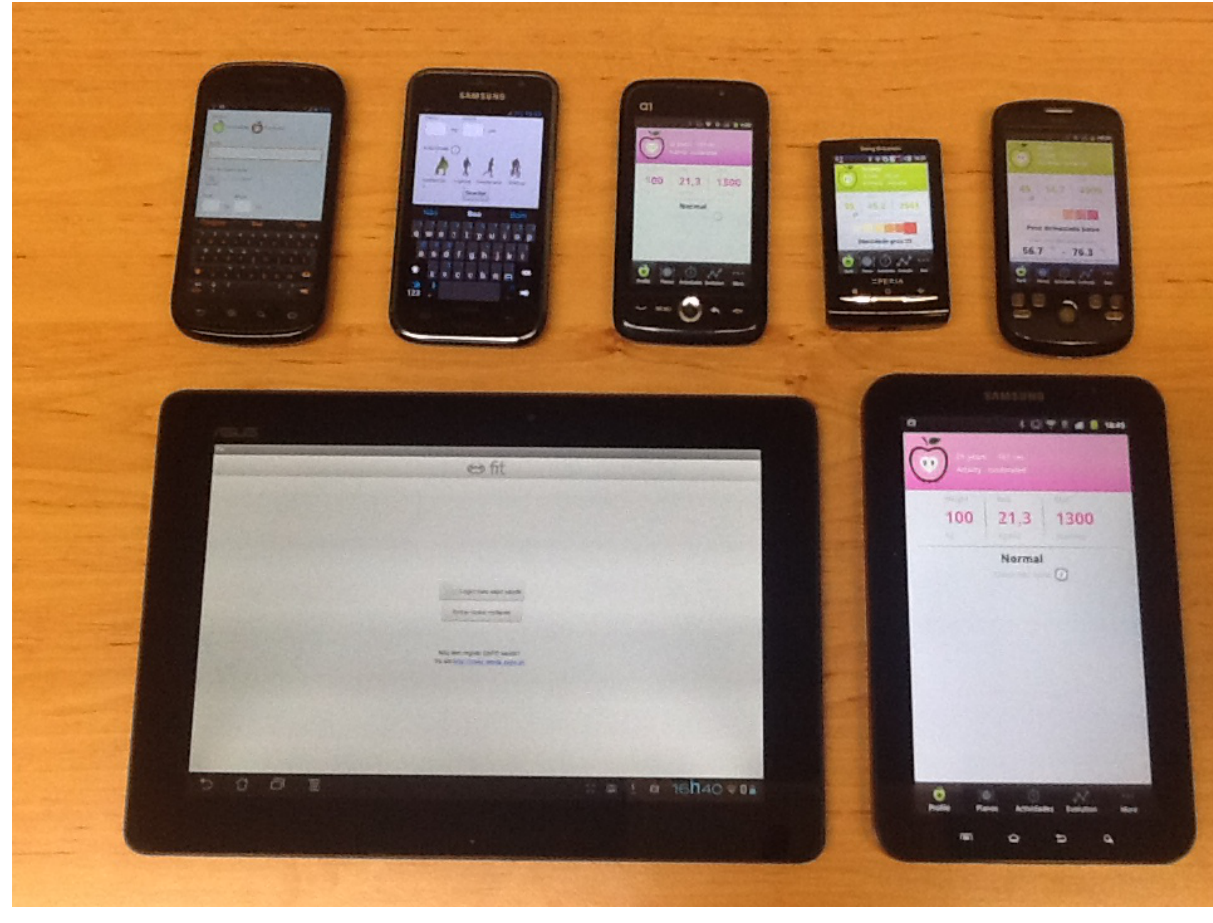
Figure 3. Mobile devices used for trials with the SapoFit mHealth